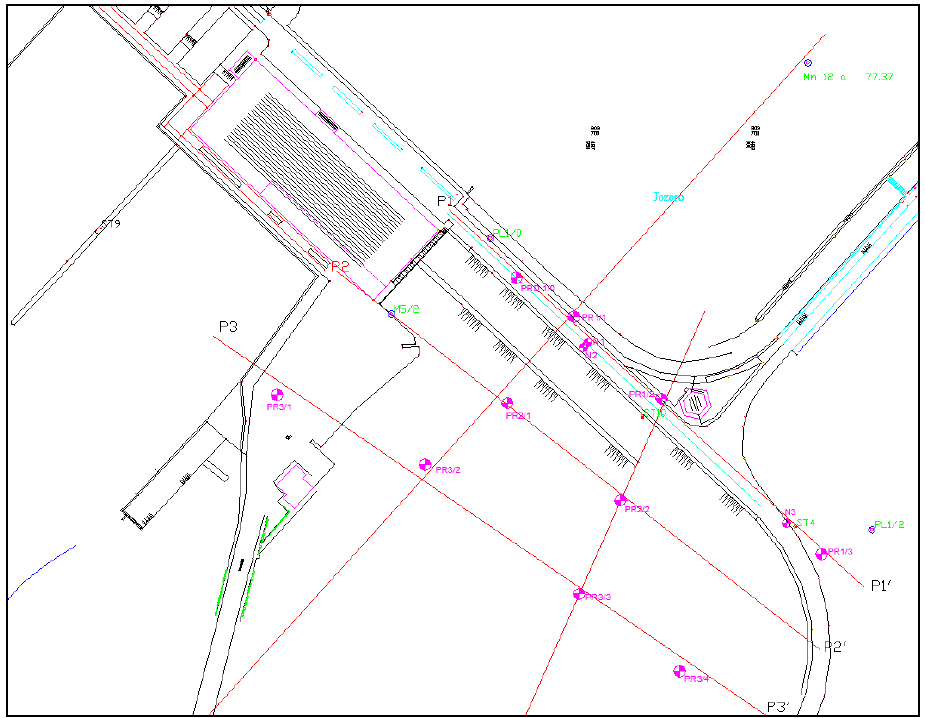
Figure 7. Scheme of the analyzed boreholes around the HEPP Mostar dam [15].